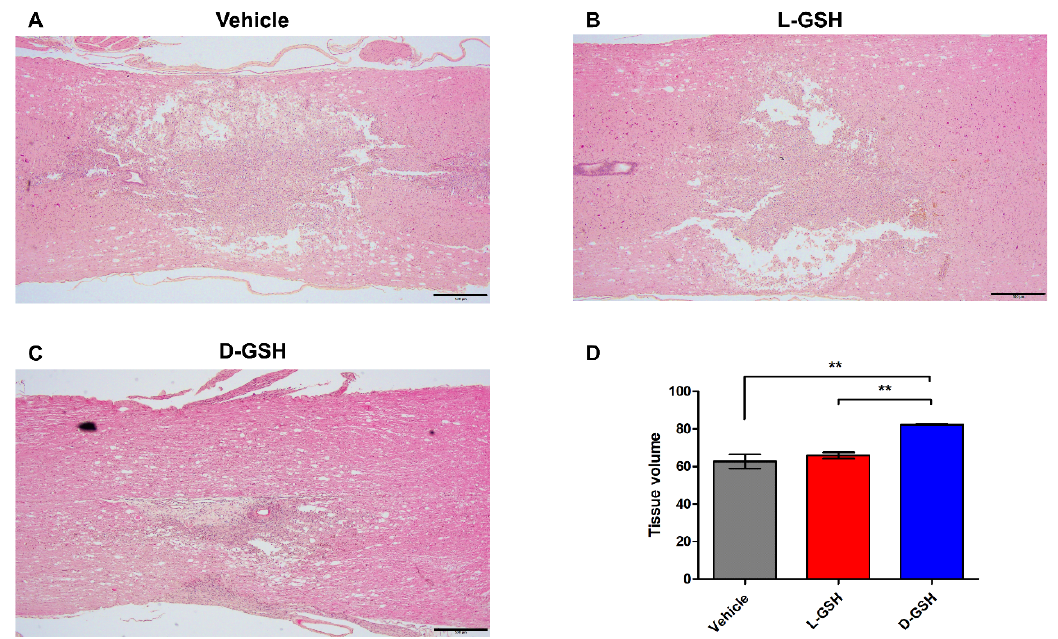
Figure 4. Histopathological changes were evaluated for the ( A ) vehicle-, ( B ) L-GSH-, and ( C ) D-GSH-treated rats. Representative images of the spinal cord stained with H&E in the vehicle, L-GSH, and D-GSH groups. ( D ) Quantitative analysis of the tissue volume. Results are the mean ± standard error of the mean (SEM), ** p < 0.01; one-way ANOVA with Tukey post hoc test.